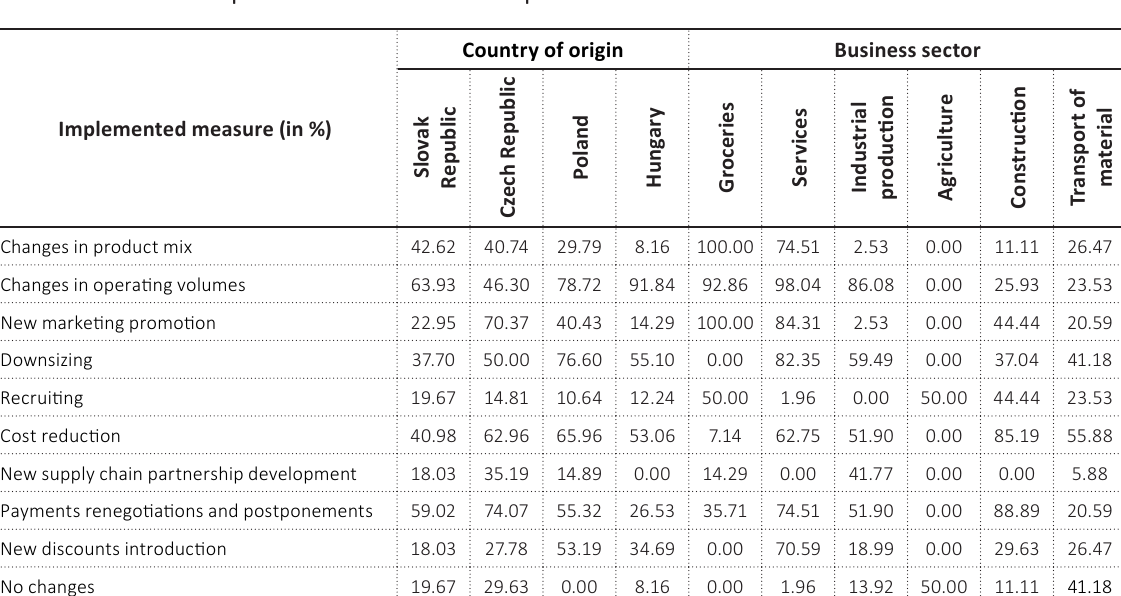
Table 5. Measures implemented as an initial response to the COVID-19 crisis